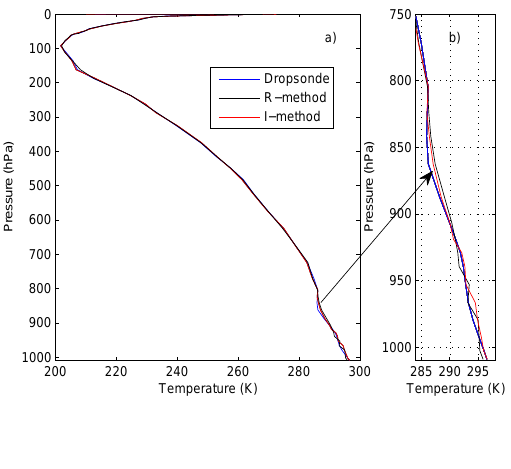
Figure 12. Results for the JAIVEx case study and for ( N = 3385 , x April 2007. The figure shows the mean retrieved profile for temperature for the two retrieval approaches and their comparison with the dropsonde observation. The retrieved profile has been averaged over the 16 available IASI